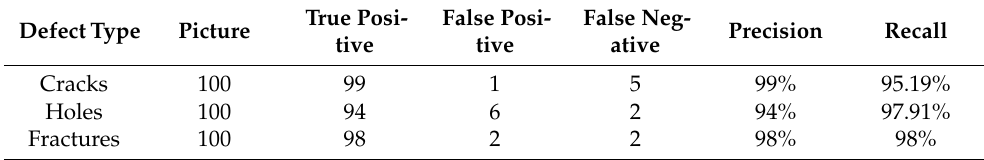
Table 1. VGG16 defect classification results.